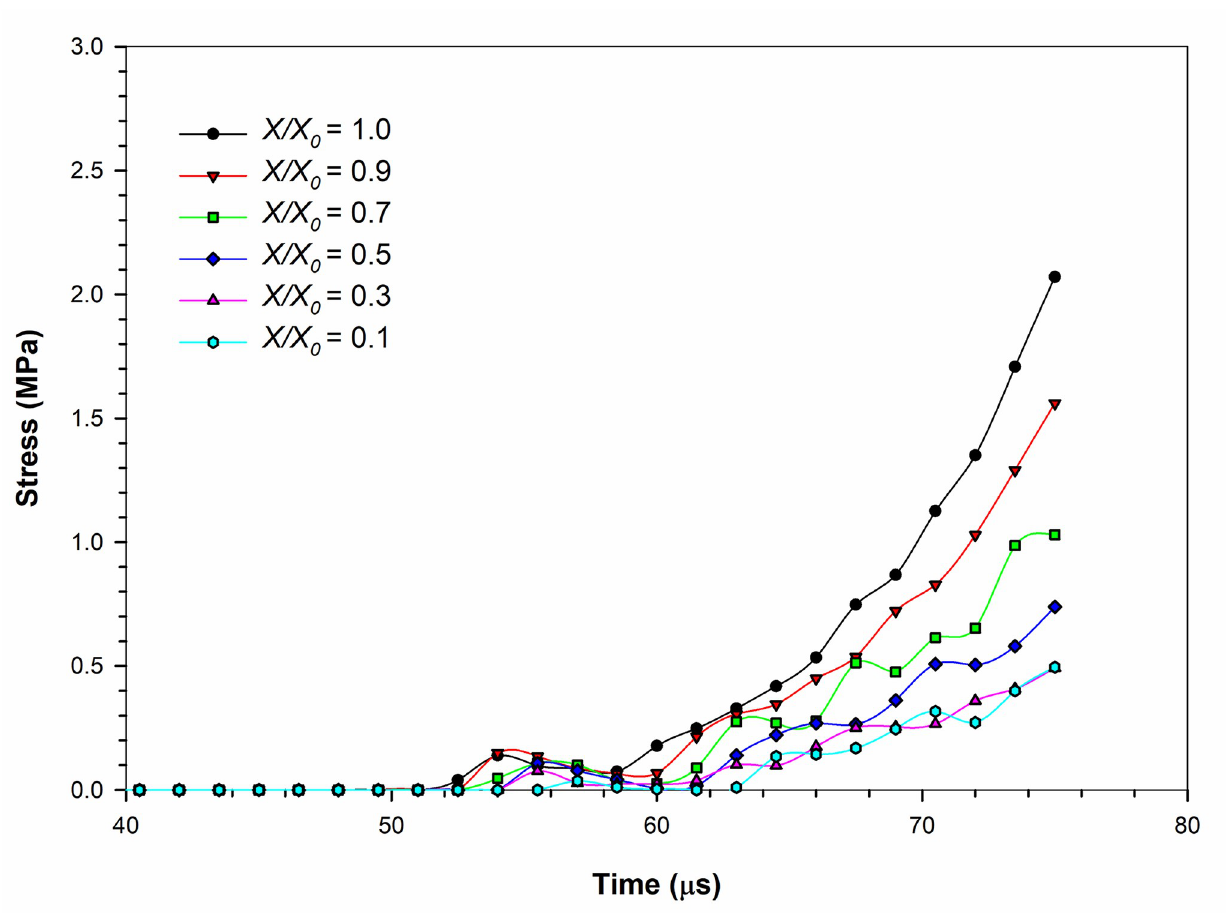
Fig 6. Variation of stress with time during the compression simulation of the SPH-CG cell drying model at a turgor pressure of 200 kPa. ( X/X normalised moisture content).